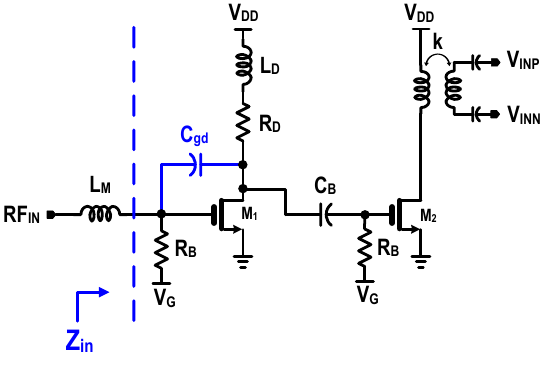
Figure 2. Schema of the